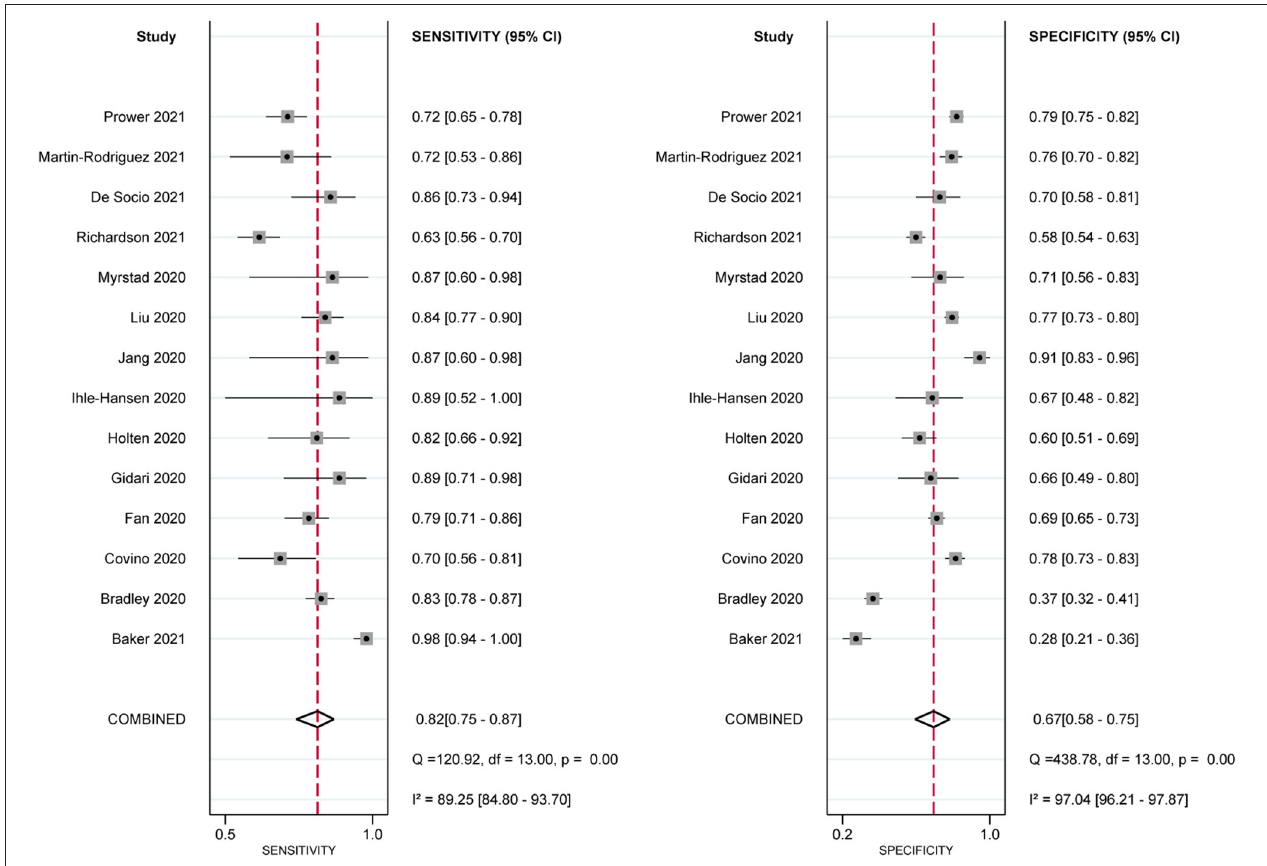
FIGURE 2 | Paired forest plots of sensitivity and specificity of National Early Warning Score 2 (NEWS2) in predicting clinical deterioration in patients with